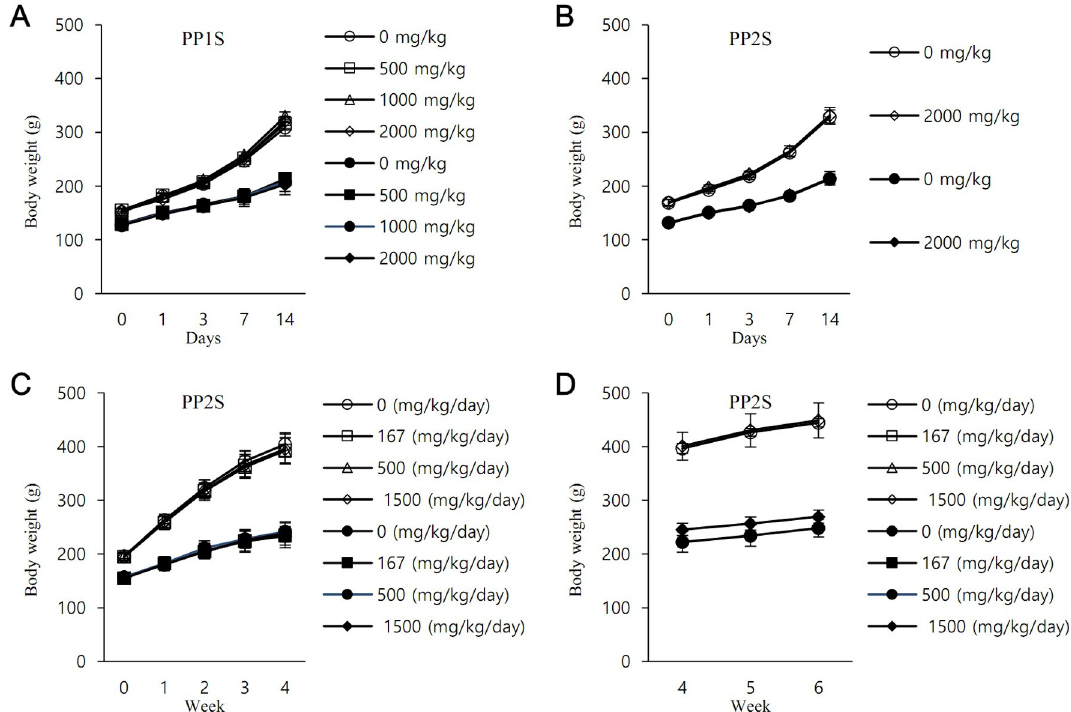
Fig 5. Body weights of SD rats after single or repeated oral administration of PPs. Bodyweight was measured for 2 weeks after a single administration of (A) PP1S or (B) PP2S. (C) PP2S was repeatedly administered for 4 weeks, and body weight was measured. (D) After the dosing period, the control and maximum administration groups had a recovery period of 2 weeks, and their body weight was continuously measured. Colored symbols indicate females and uncolored symbols indicate males. PP, methyl (S)-1-((3-alkoxy- 6,7-dimethoxyphenanthren-9-yl)methyl)-5-oxopyrrolidine-2-carboxylate; SD, Sprague Dawley. Data underlying this Figure can be found in S1 Data.